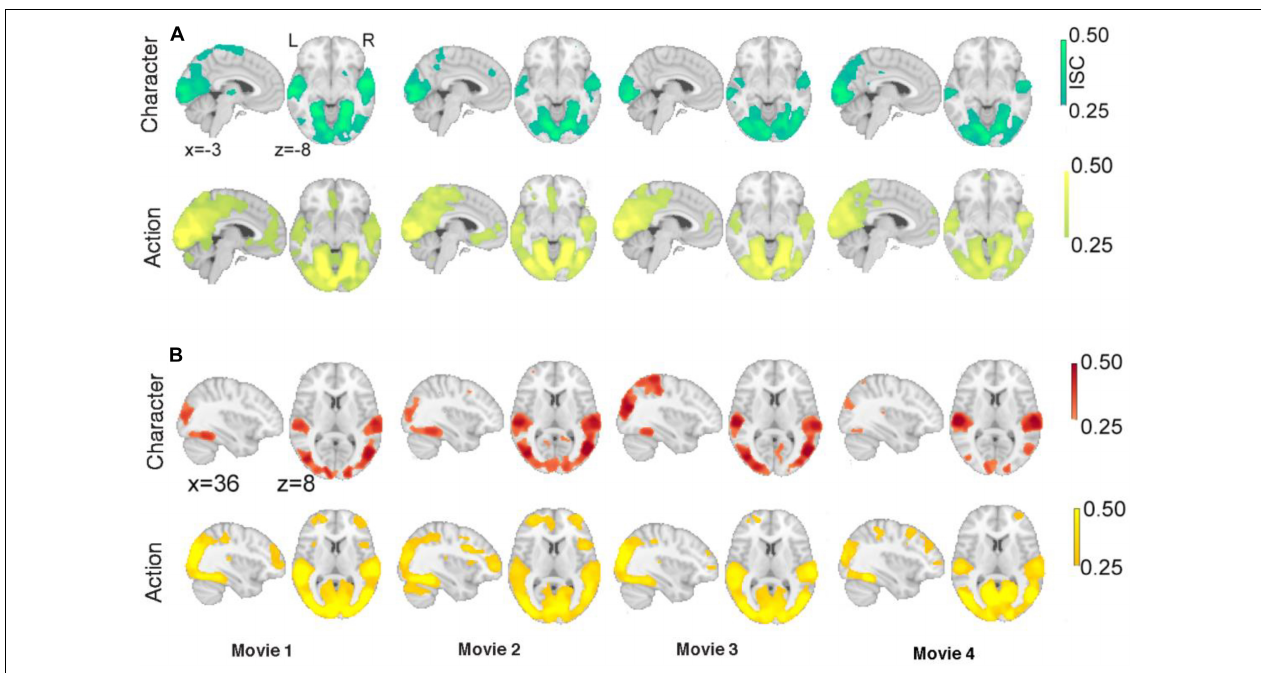
FIGURE 4 | Intersubject correlations during action segments compared to during character segments. Significant ISCs of (A) justified movie clips for character and action segments and (B) unjustified movie clips for character and action segments. The color bar provides ISC values, with a significance threshold set at r < 0.25, after applying a non-parametric family wise error, FWE, correction of q <